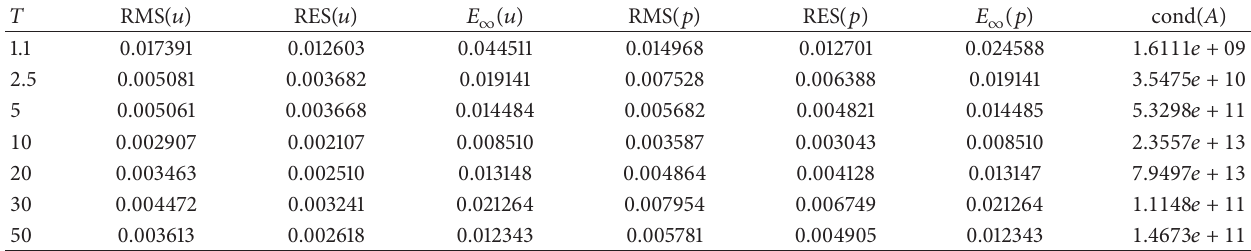
Table 2: The obtained values of RMS (𝑢), RES (𝑢), RMS (𝑝) , and RES (𝑝) using MFSRBF for various values of 𝑇 , 𝑥 0 = 0.5 , and 𝛿 = 0.01 by solving problem A .